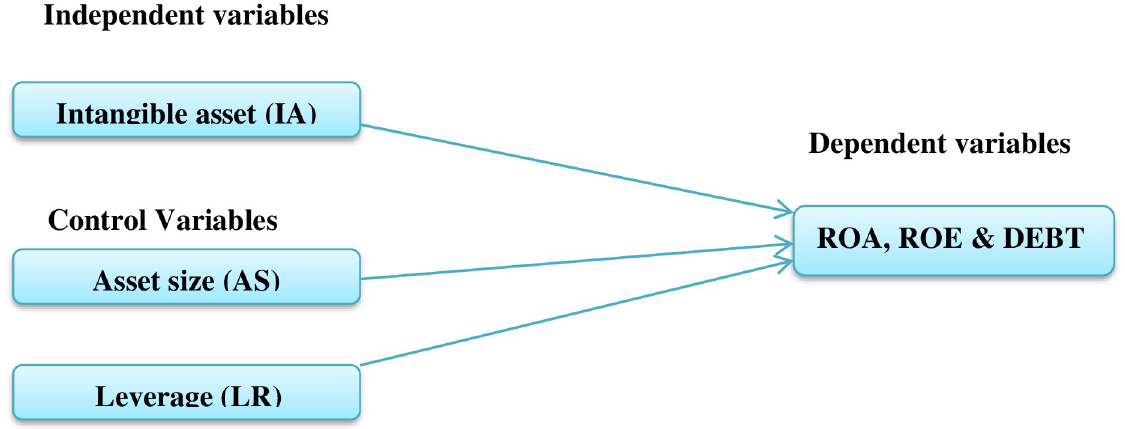
Fig 1. Conceptual framework. Sources: Own design